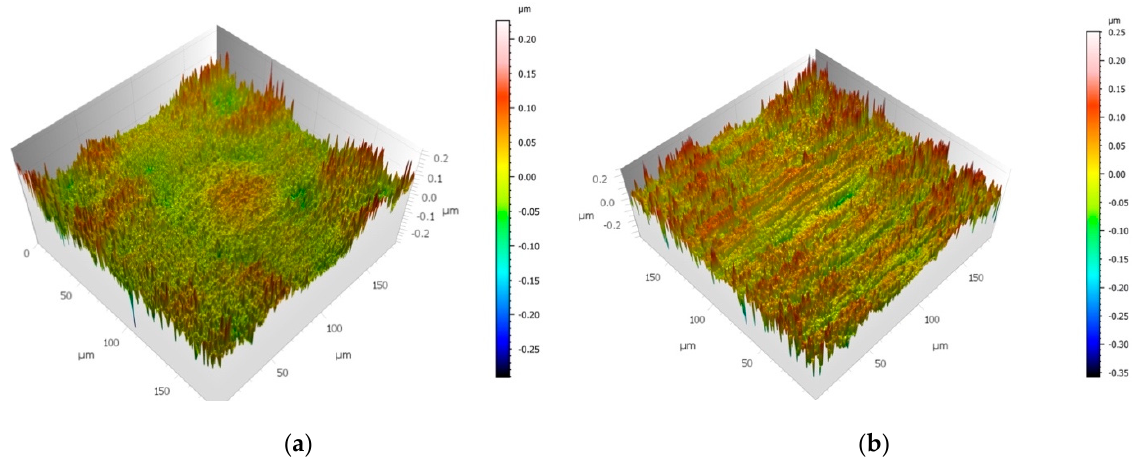
Figure 2. Three-dimensional topographic maps measured with an optical profilometer for two representative AISI 430 ferritic stainless steel samples with different visual appearances: with a mirror-like finish ( a ) and with a presence of haze ( b ).